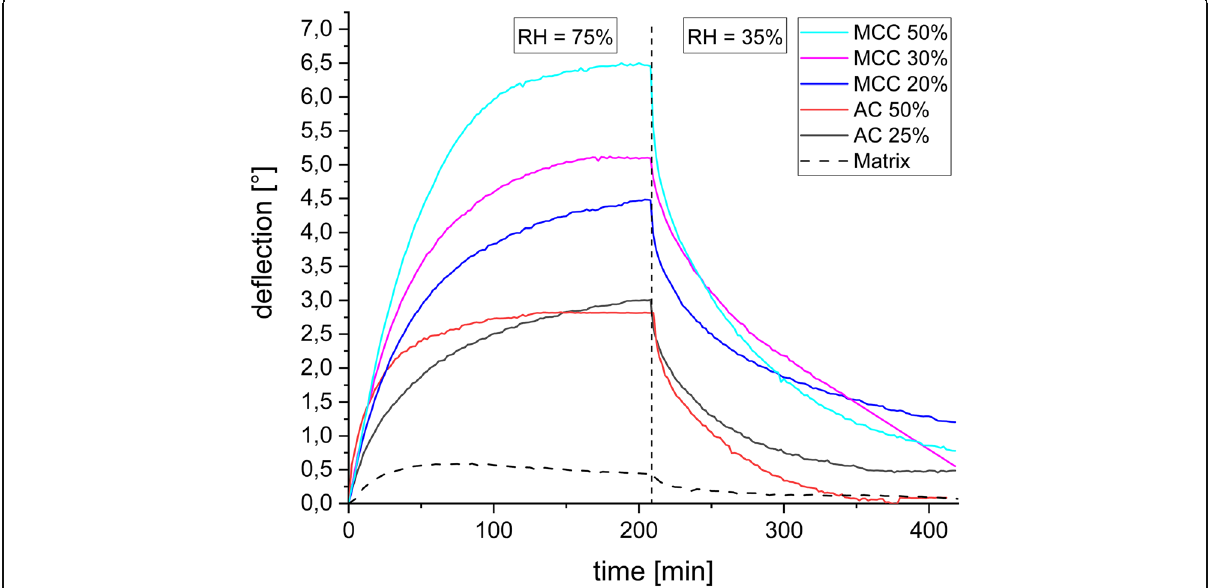
Fig. 5 Plot of the tip deflection versus time of all printed bilayers and the matrix during exposure to a relative humidity of 75% for 210 min and subsequent drying in ambient air by removing the water dish out of the climate chamber. The initial position of the equilibrated bilayer at ambient air was taken as the reference with θ ambient air =